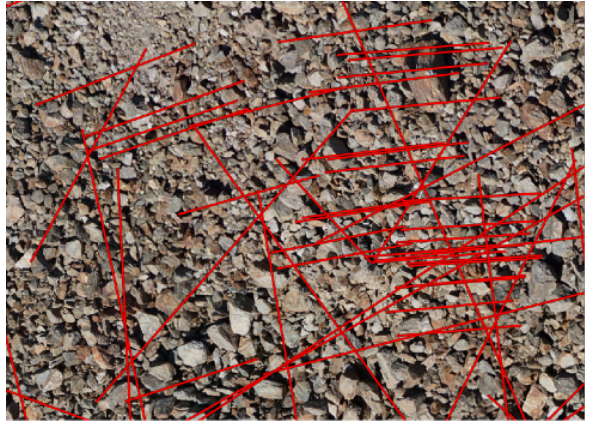
Figure 6. Tie point matching 2017-2018